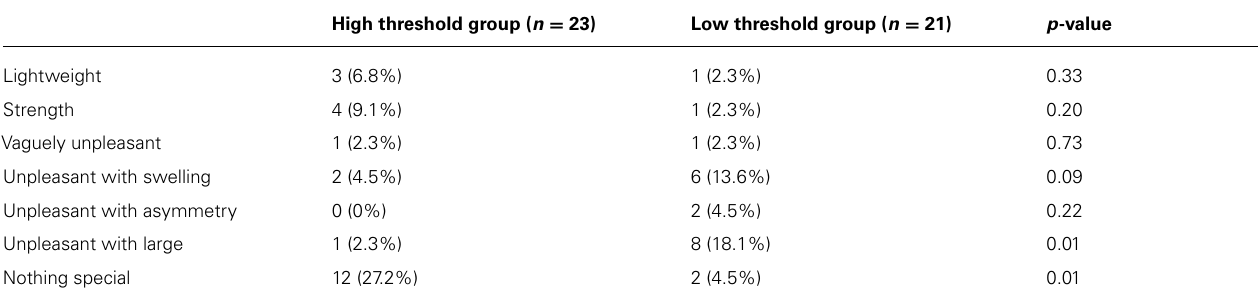
Table 1 | Response frequencies for magnified mirror image of the hand in both the high threshold and low threshold groups.